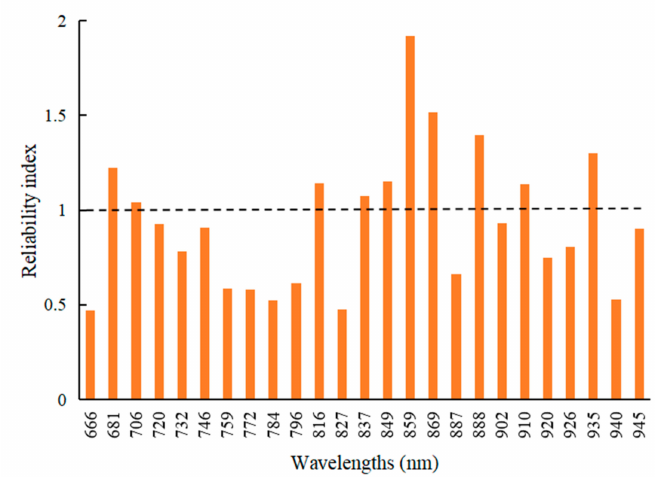
Figure 11. The run result of uninformative variable